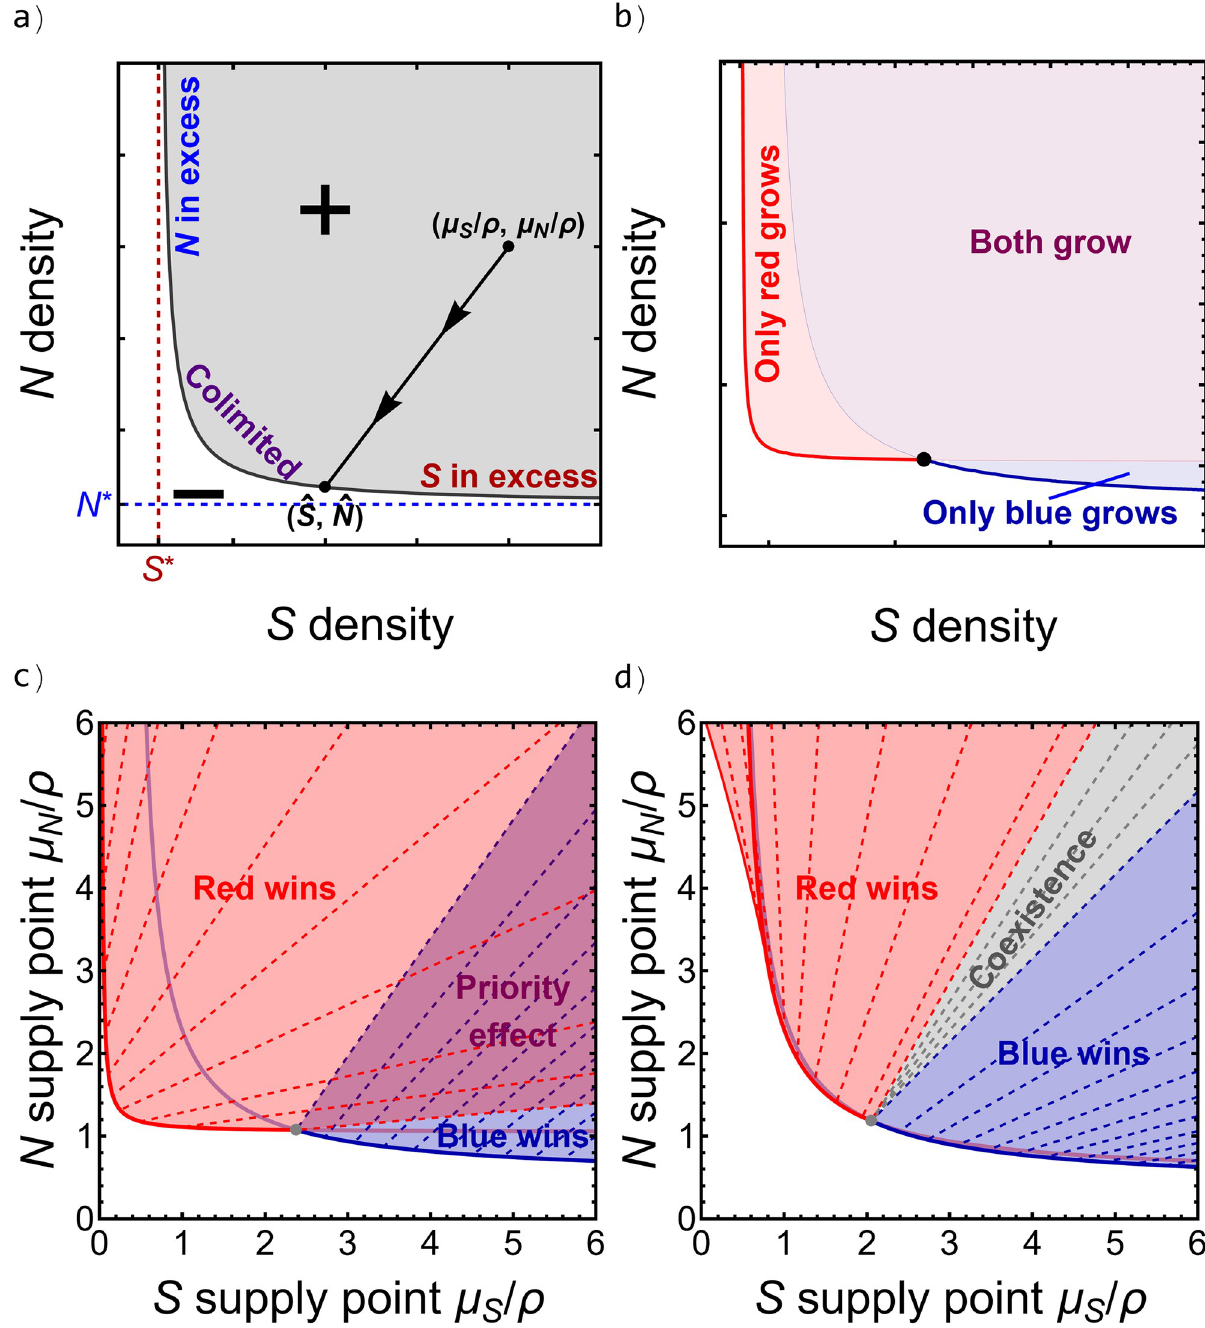
Fig 3. Graphical analysis of consumer-resource models (see Box 1 for details). (a) Illustration of a zero net growth isocline (ZNGI, gray curve) for a cell population as a function of resource availabilities. The shaded region marked with a “+” denotes the resource levels for which the strain can grow. Whether S , N , or both resources are limiting depends on the resource availabilities relative to the minimum individual concentrations required for growth ( S � , N � ). Impact vectors (the thick line with arrows is one example) map resource supplies onto equilibrium resource concentrations. (b) Drawing ZNGIs for two different strains allows for an assessment of the conditions in which both (purple) or only one (red or blue) strain can grow. (c) The outcome of competition between two strains also requires knowledge of how they influence the environment (their impact vectors; dashed lines). Here, coexistence (necessarily at the intersection of the two ZNGIs) is unstable (a priority effect) because each strain draws down the resource that its competitor most needs to grow more than the resource that it itself most needs to grow. (d) Stable coexistence happens when each strain draws down the resource that it most needs to grow more than the resource that its competitor most needs to